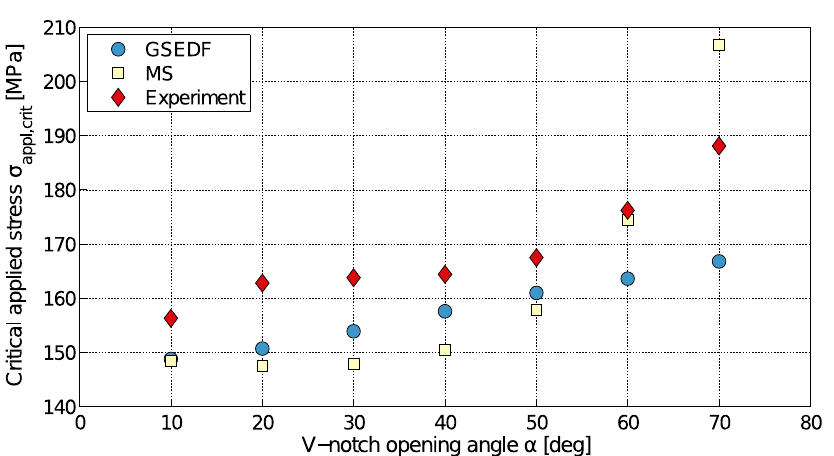
 for different V-notch opening angle  and both stability criteria: Figure 3: Estimated values of the critical applied stress , appl crit based on generalized strain energy density factor (GSEDF) and on the mean stress ahead of the V-notch (MS). Material duraluminum.